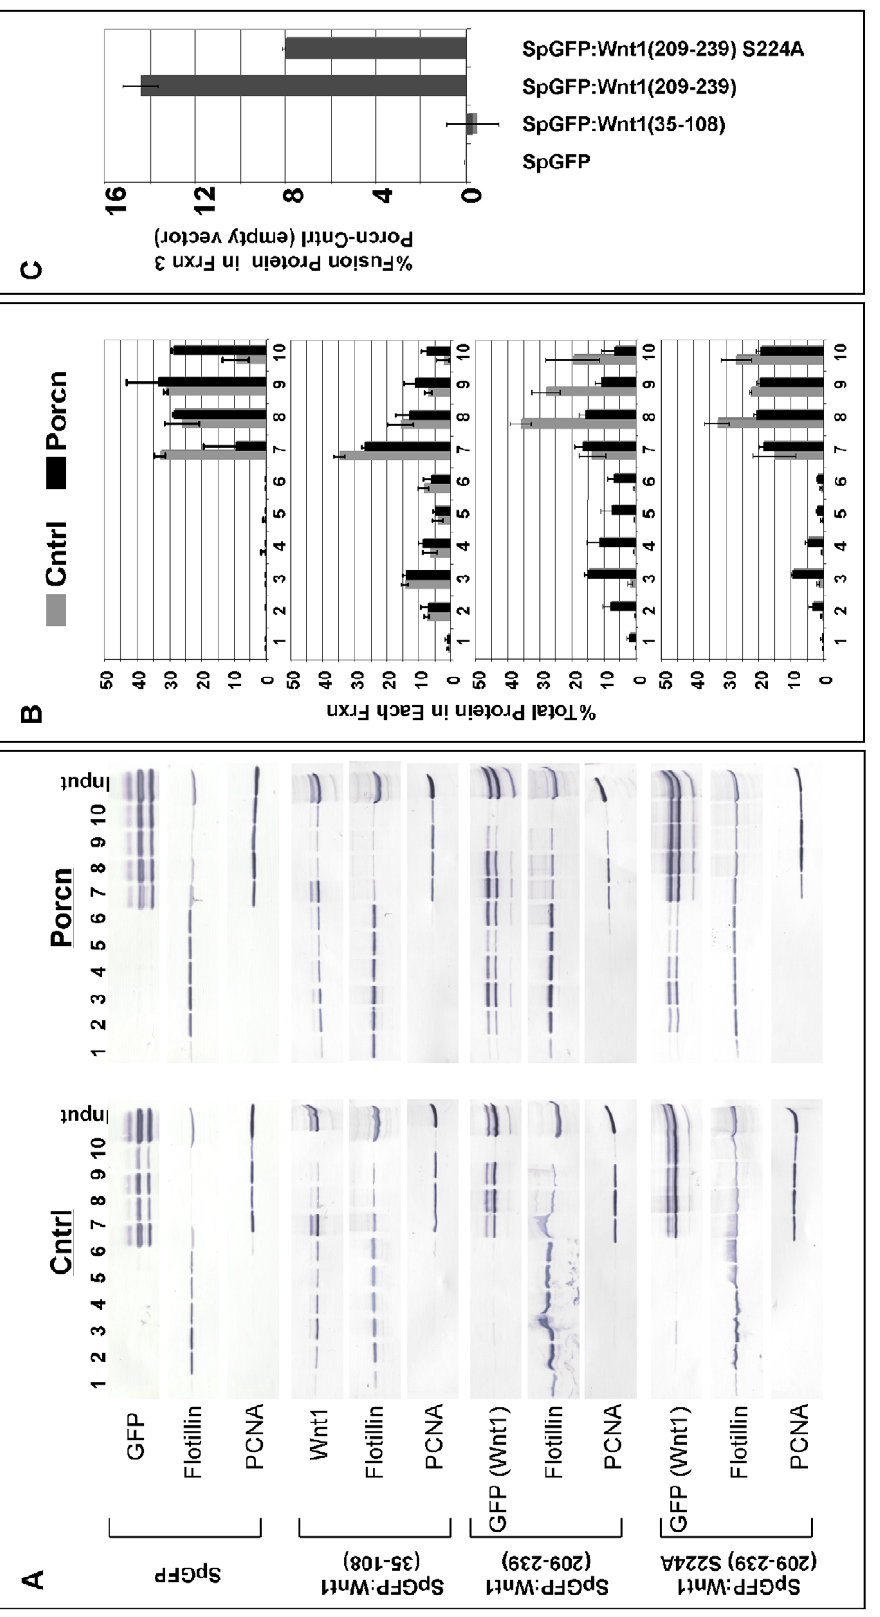
Figure 10. Porcn overexpression increases the association of spGFP:Wnt1 (209–239), but not spGFP:Wnt1 (35–108) with lipid rafts. HEK293T cells were transiently transfected with selected spGFP:Wnt1 constructs along with empty vector (Cntrl) or Porcn. Cell lysates were separated